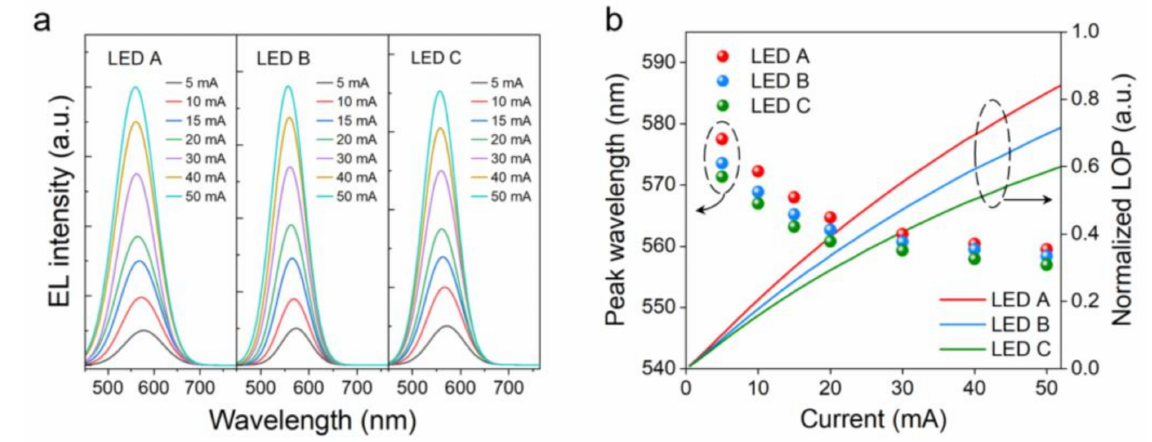
Figure 2. ( a ) Room-temperature EL spectra of LEDs A, B and C as functions of injection currents. ( b ) Normalized LOP and EL peak wavelength as functions of injection currents.